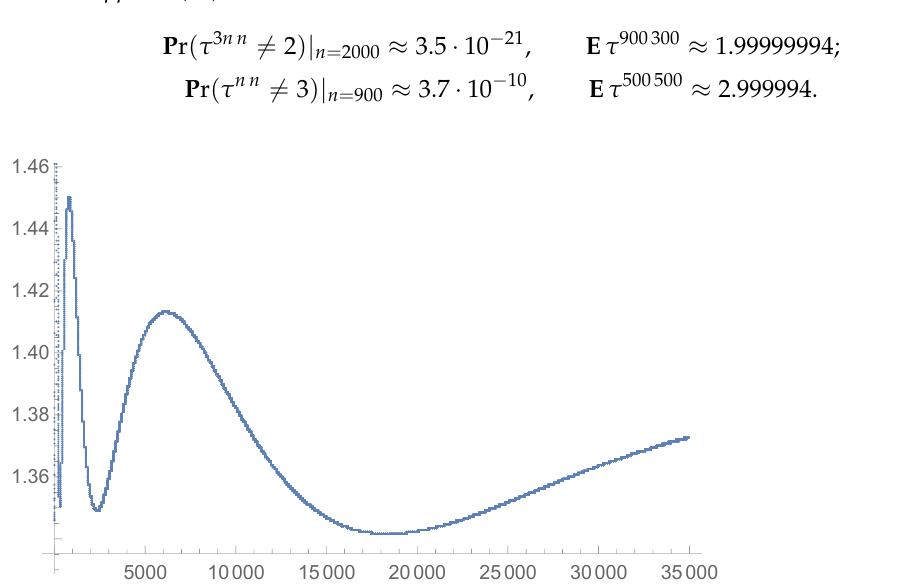
− 1 ) as an approximation for h ( x ) − x − ln ( n 50 2 50